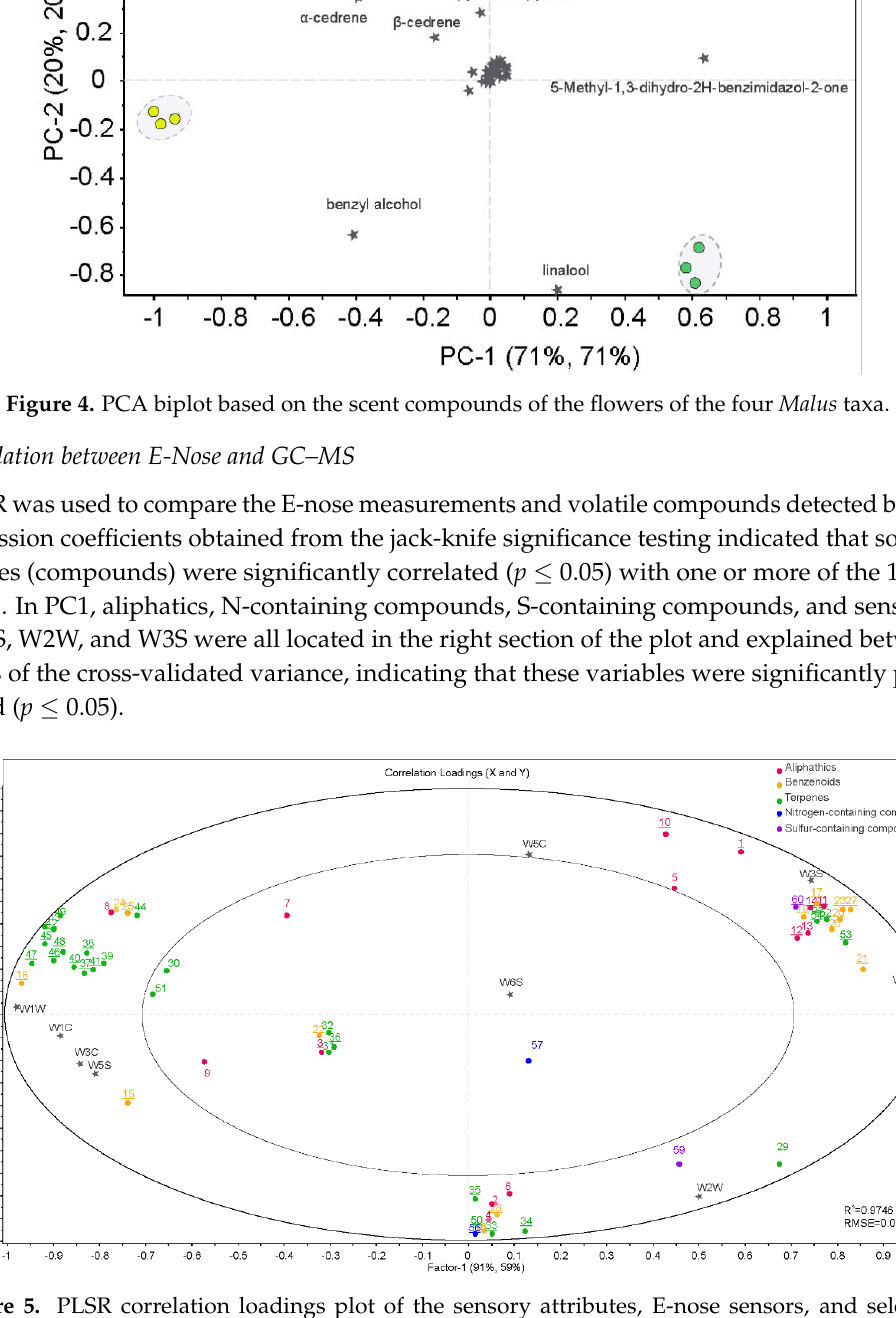
Figure 5. PLSR correlation loadings plot of the sensory attributes, E-nose sensors, and selected compounds of the four Malus taxa. The numbers 1–60 correspond to the compound codes indicated in Table 2.